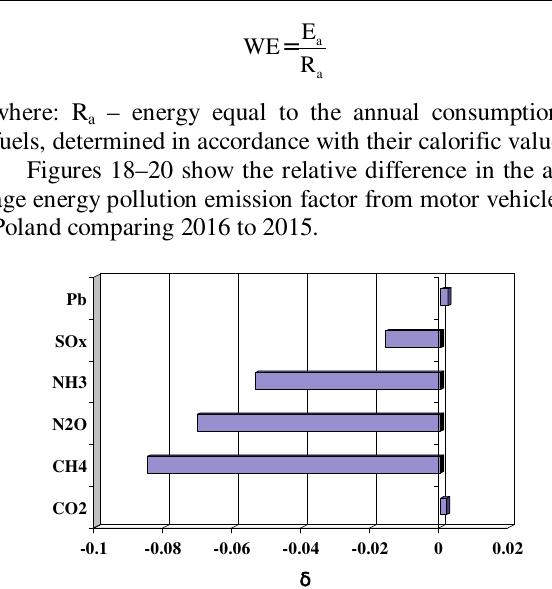
Fig. 19. The relative difference of average energetic index of pollutant emission from motor vehicles in Poland comparing 2015 to 2016